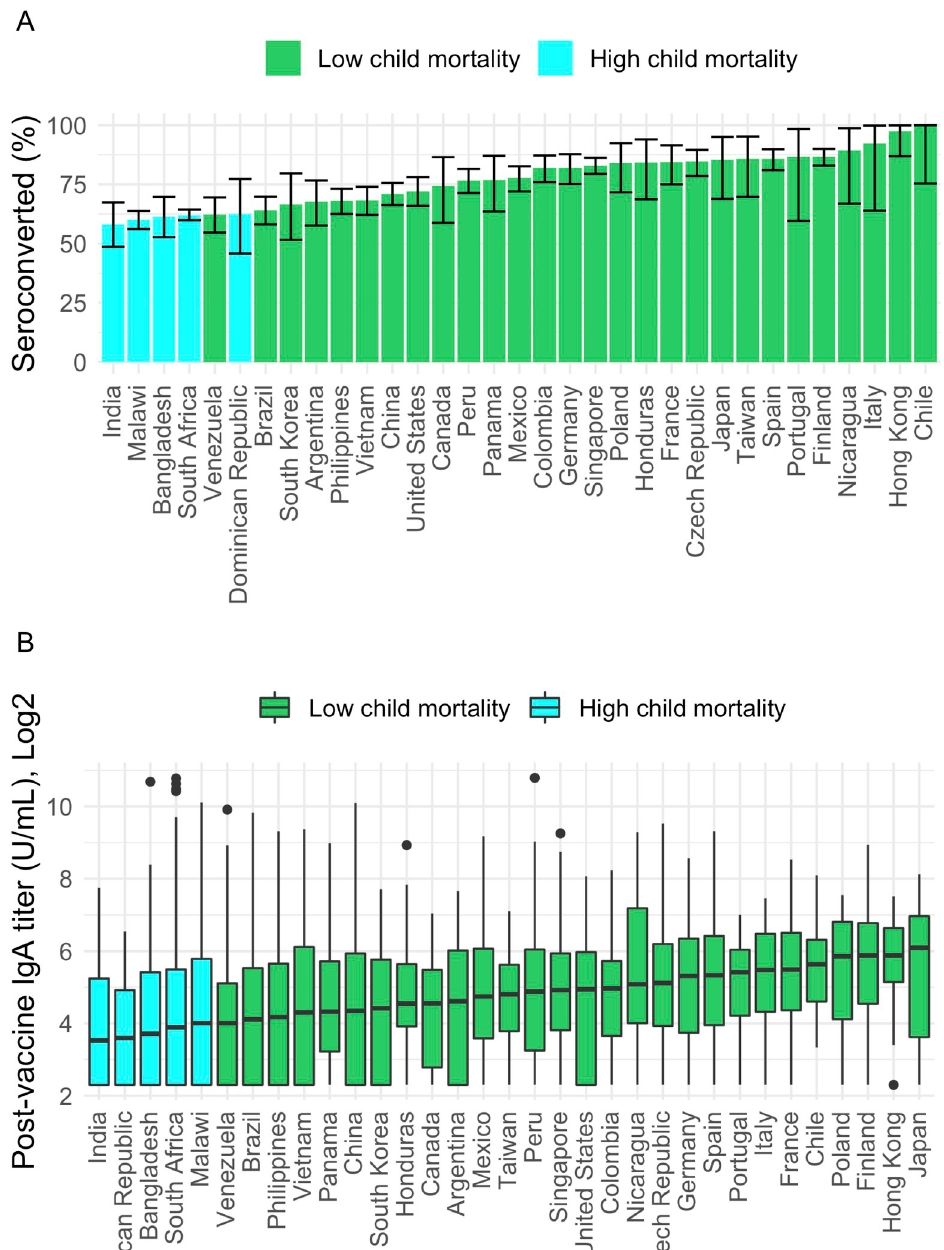
Fig 2. Percent of infants who seroconverted by country and postvaccine antirotavirus IgA titer (U/mL) by country. (A) Colored bars represent the percentage of infants in a given country that seroconverted, defined as a serum antirotavirus IgA titer � 20 U/mL. Error bars indicate the 95% confidence interval. (B) Colored bars represent median and IQR for postvaccine antirotavirus IgA titer. Lines represent 25th percentile − 1.5 � IQR and 75th percentile + 1.5 � IQR, with dots representing outliers below or above these lines (Tukey box plot method). IgA, immunoglobulin A; IQR, interquartile range. measures of various factors and when OPV was forced to remain in the model (based on its importance in seroconversion models), the results varied minimally. Increased time from last rotavirus dose to serology sample was negatively associated with antirotavirus IgA titer. Among infants who seroconverted, concomitant OPV with rotavirus doses 1 and 2 was